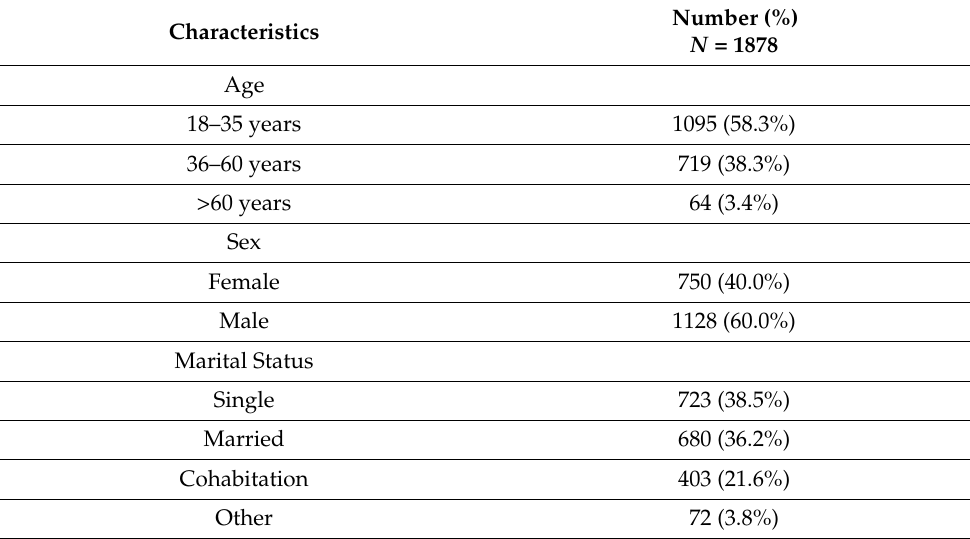
Table 1. Socio-demographic characteristics of the